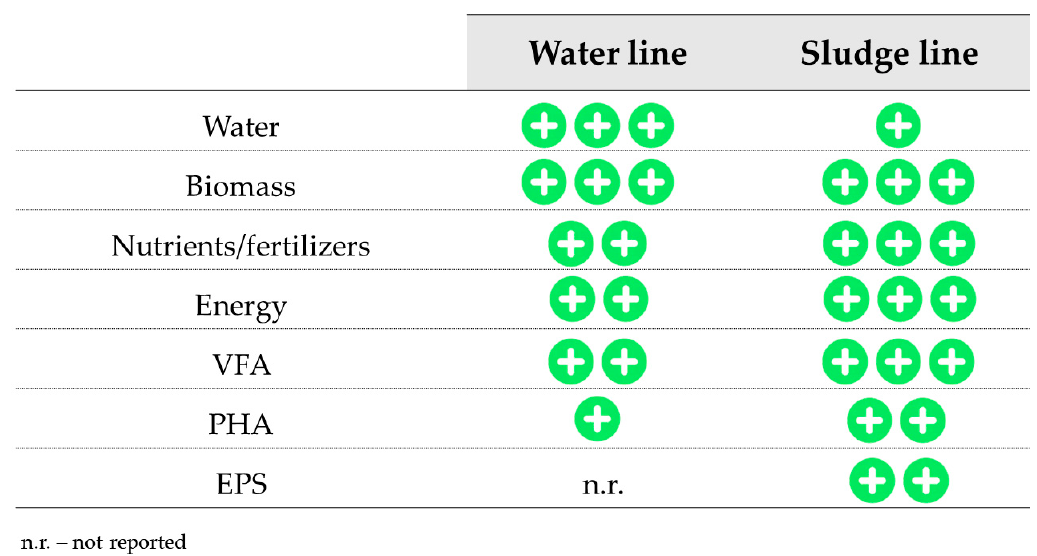
Figure 2. Summary of the resources recovered from wastewater reviewed in this study, with indication of the relative abundance of routes applied to the water and sludge lines.